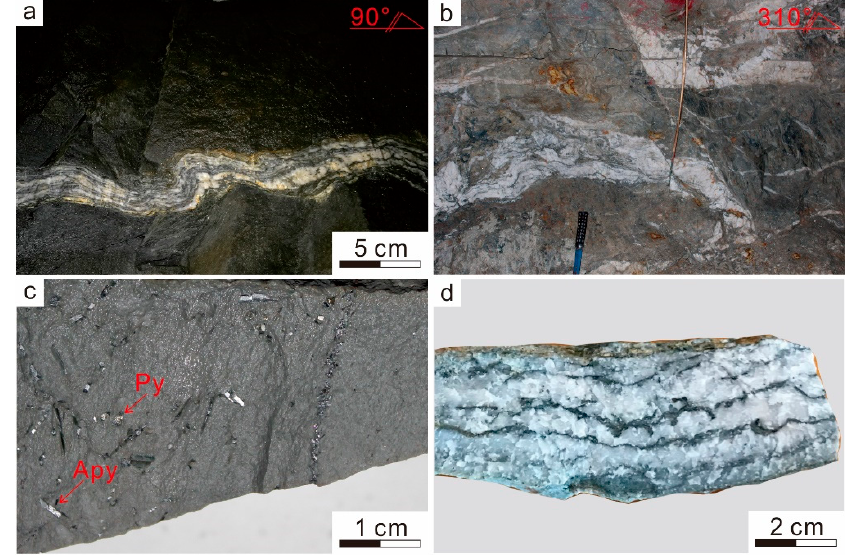
Figure 3. Photographs of representative ore styles at the Zhengchong gold deposit. ( a ) Auriferous arsenopyrite-pyrite-quartz vein folded in disseminated mineralized slate adjacent to the fault; ( b ) Auriferous arsenopyrite-pyrite-quartz vein cut by the post-fault; ( c ) Altered slate with disseminated arsenopyrite and pyrite; ( d ) A typical crack-seal structure showing white barren quartz vein with fractures infilled by the sulfides with fine-grained quartz and muscovite. Py-pyrite; Apy-arsenopyrite.